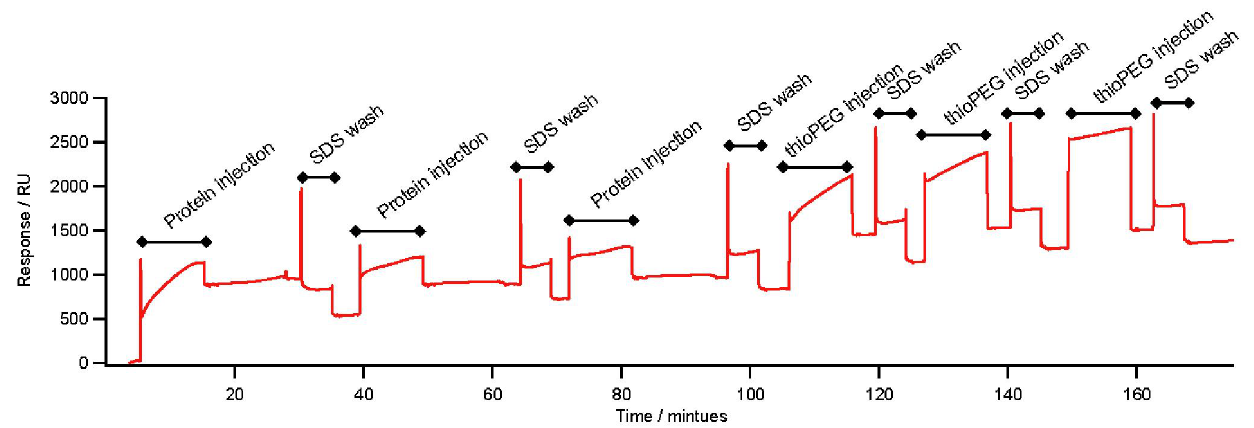
Figure 3. SPR trace of the assembly of ZZlinkZZctOmpA on gold. The assembly was carried out on a BIAcore X instrument using Au sensor chips. 25 μL of ZZlinkZZctOmpA (0.20 mg mL −1 ) was injected in to the flow cell at 5 μL min −1 . Each protein injection was followed with an injection of 1% SDS at 5 μL min −1 to remove any non-specifically bound protein. After protein depositions a filling molecule, thioPEG was deposited. ThioPEG at 0.25 mg mL −1 in a solution of 1% OG 10 mM Tris-HCl pH 8.0 and 1 mM TCEP was injected into the flow cell at 5 μL min −1 . As with the protein depositions each injection was followed by a 1% SDS wash to remove non-specifically bound material. The unlabelled sections of the trace are a PBS buffer